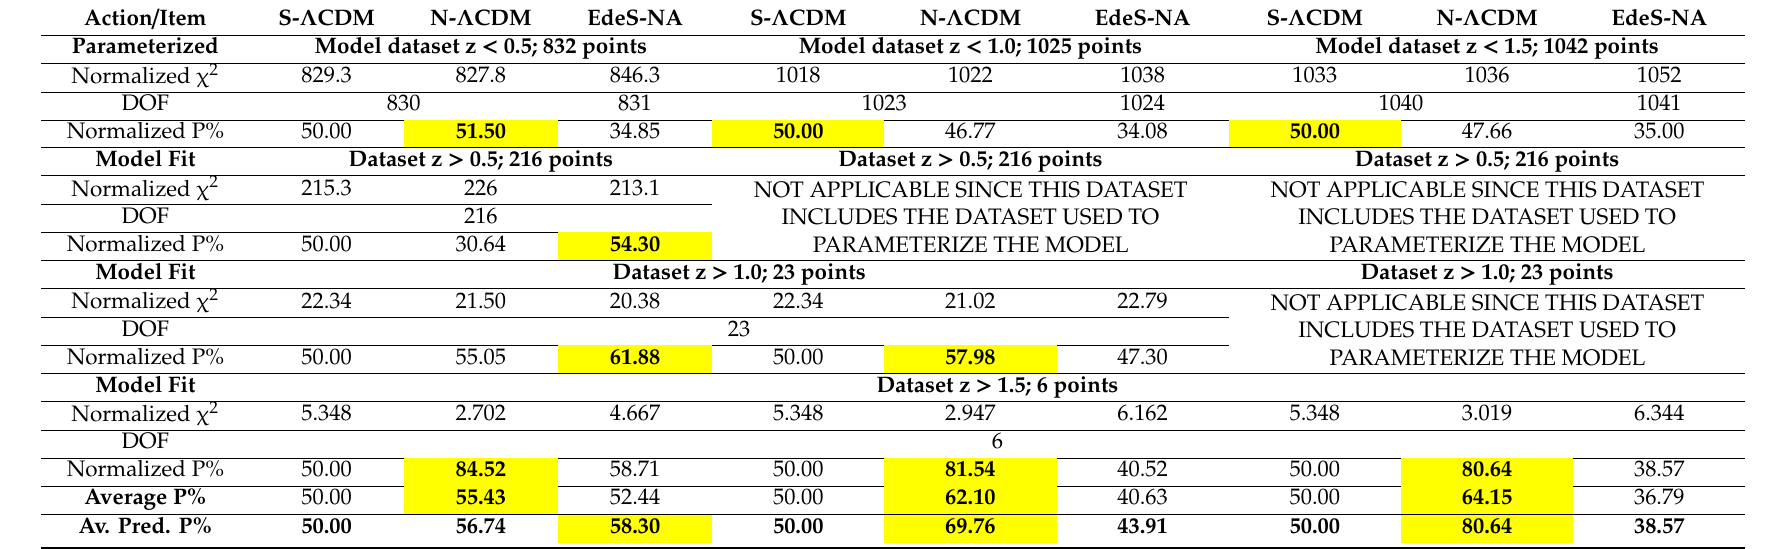
Table 2. Summary of the goodness-of-fit parameters corresponding to Table 1 with normalized χ 2 . This table is based on the normalized χ 2 such that the χ 2 probability P for the S- Λ CDM model in each category is 50%. Highest P % value in each category is shown in bold and the cell highlighted. The last but one row shows the average P% in each column whereas the last row shows the average predictive P % in each